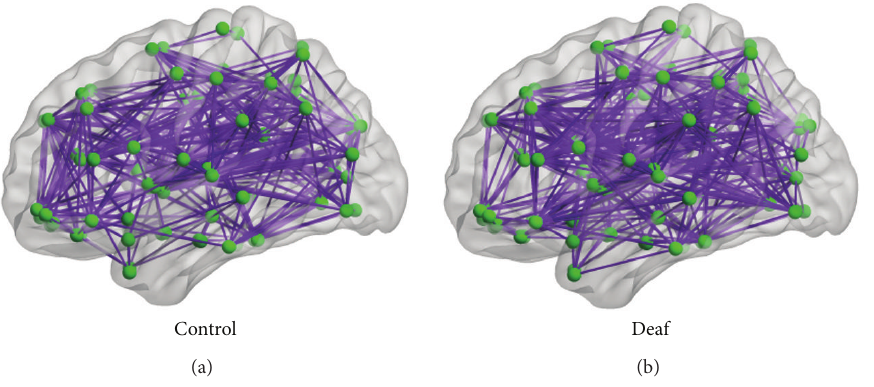
Figure 1: 3D views of functional connectivity patterns in normal controls (a) and prelingually deaf adolescents (b).